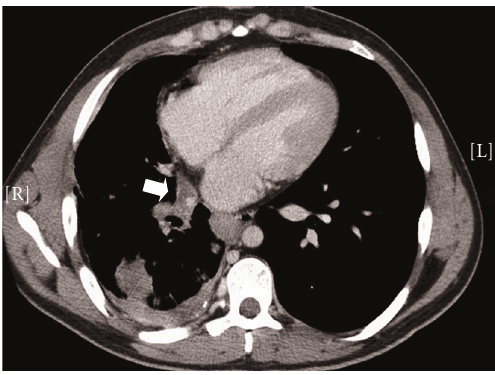
Figure 2: Contrast computerized tomography scan of the thorax showing right pulmonary venous obstruction (arrow), right lung consolidation and posterior pleural e ff